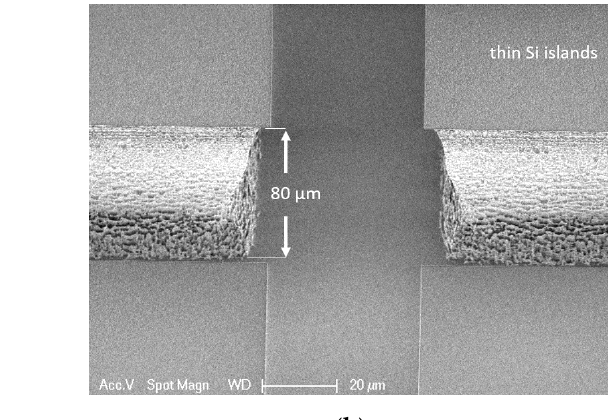
Figure 7. ( a ) Backside etching result of a silicon substrate, landing on cavity-BOX. ( b ) Etching device layer while using the patterned cavity-BOX as a mask, landing on polyimide.